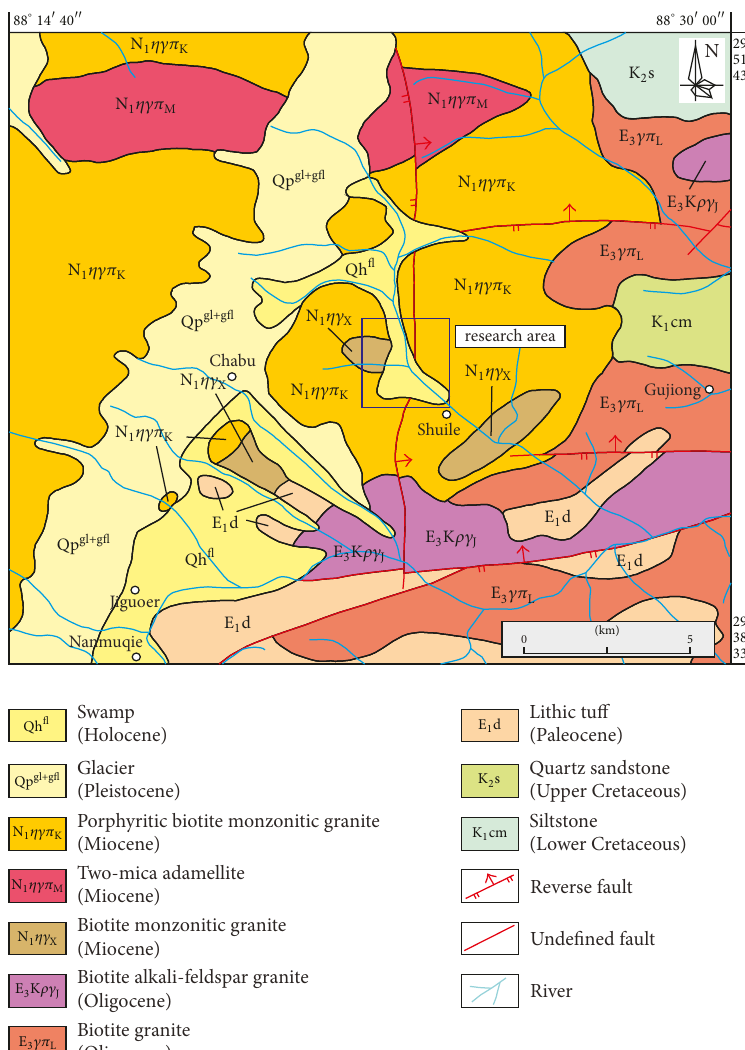
Figure 2: Geological map of the research